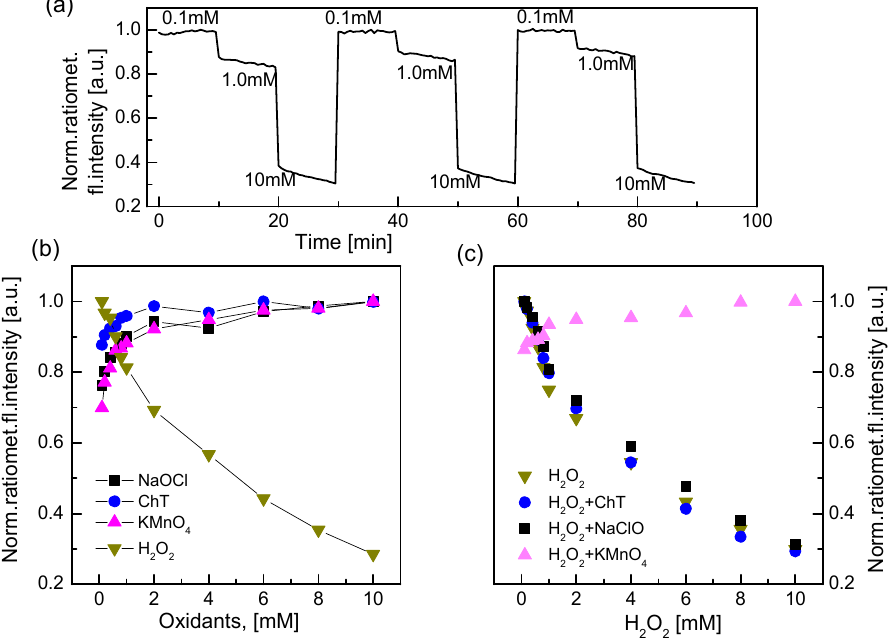
Figure 3. ( a ) Response of the QD–AF membrane when it is exposed to H 2 O 2 at di ff erent concentrations (0.1, 1.0, and 10 mM) and its reproducibility when repeating the cycle. ( b ) Response of the QD–AF membrane to di ff erent concentrations of various oxidants. ( c ) Response of the QD–AF membrane to di ff erent concentrations of H 2 O 2 and a fixed concentration of each oxidizing agent (1